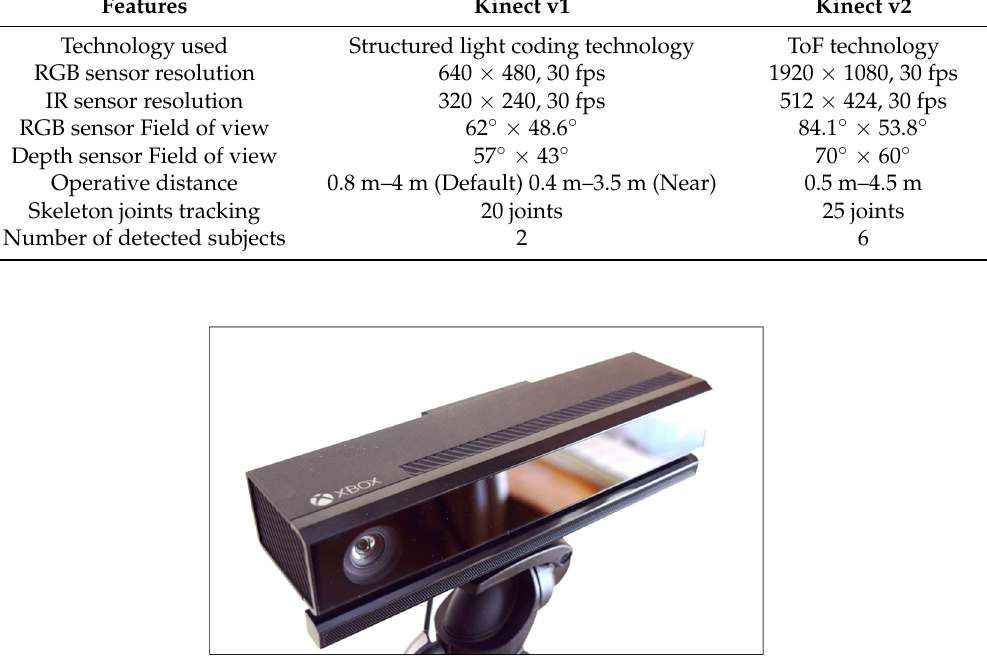
Figure 1. Microsoft Kinect v2 sensor.